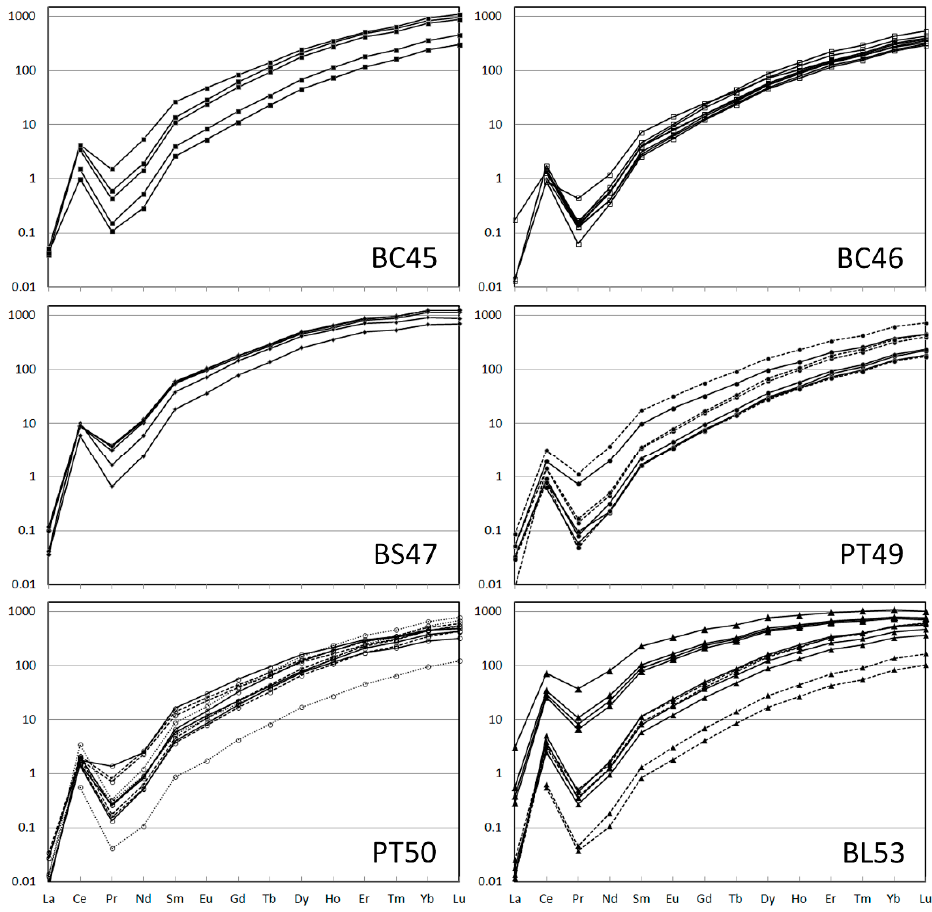
Figure 9. Average chondrite-normalized REE patterns for RVP zircon xenocrysts.